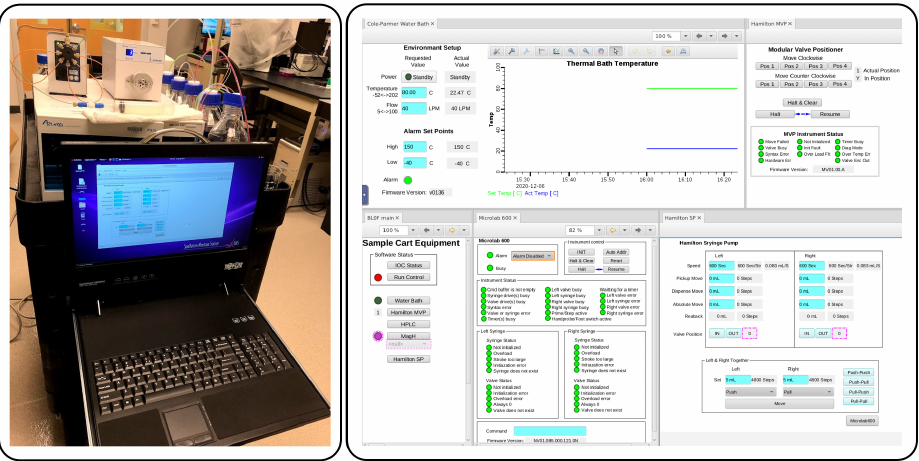
Figure 5. Visual of the cart ( left ) and the software interface ( right